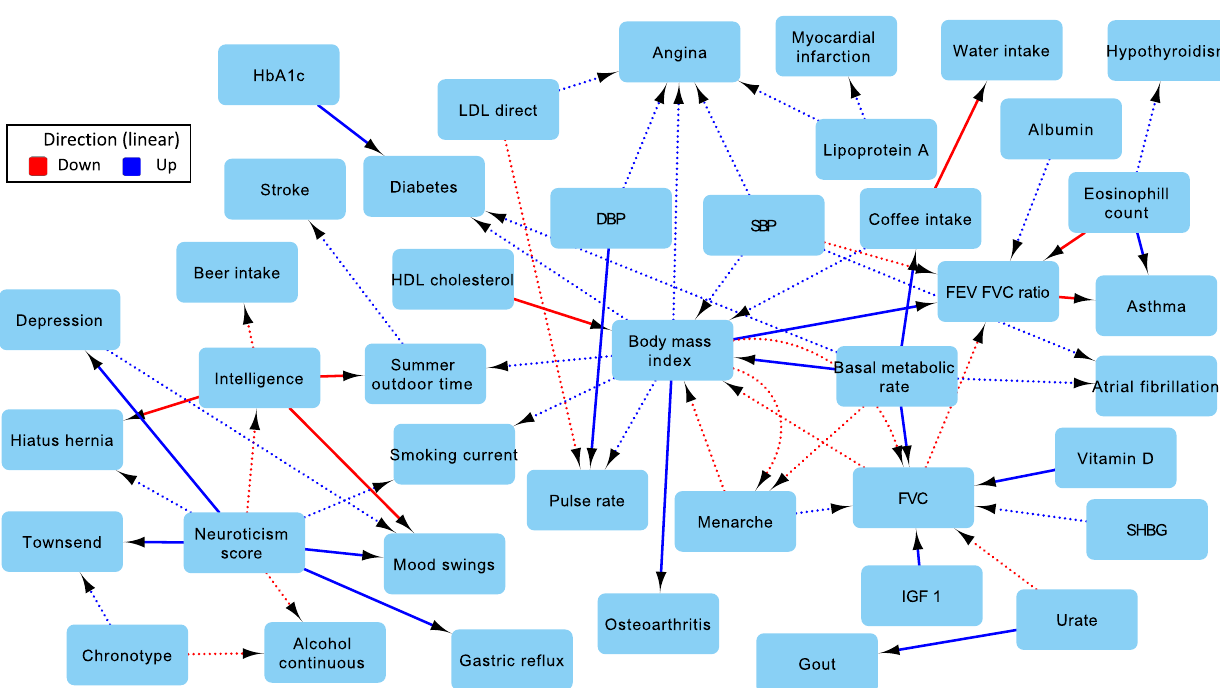
Fig. 5 cGAUGE MR analysis with p 1 = 1 × 10 − 07 and p 2 = 0.001. All presented links were detected at 10% BY FDR correction and had π 1 > 0.25. Solid arrows represent G T edges (phenotypes whose correlation is robust to conditioning) and dashed arrows represent G T non-edges. For simplicity, we excluded waist circumference and height, arrows out of diseases, and arrows into biomarkers. DBP diastolic blood pressure, SBP systolic blood pressure, HbA1c hemoglobin A1c levels, FEV forced expiratory volume, FVC forced vital capacity, IGF1 insulin like growth factor 1 levels, LDL direct low-density lipoprotein levels, HDL cholesterol high-density lipoprotein levels, SHBG sex hormone-binding globulin levels.